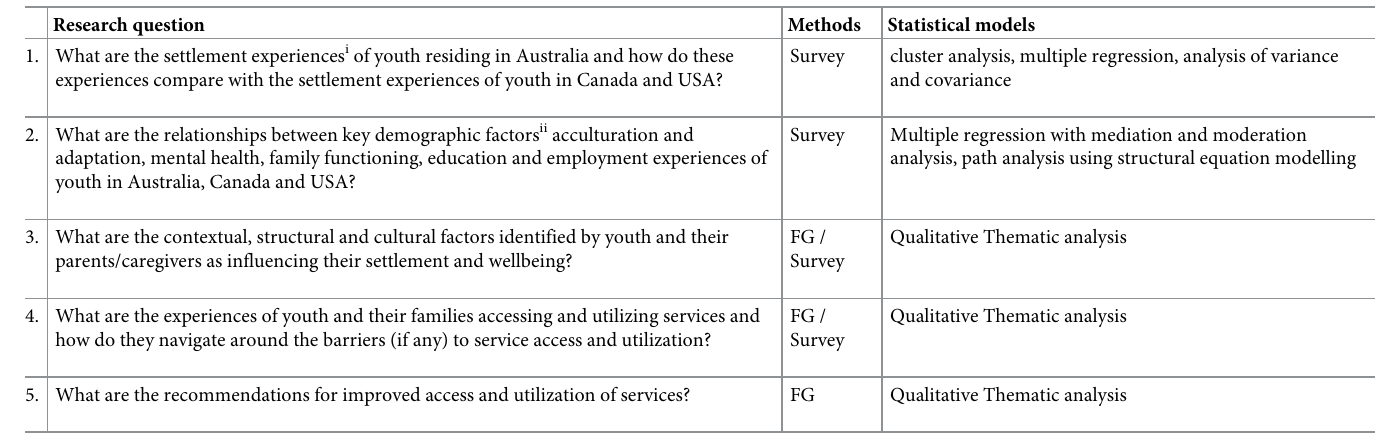
Table 3. Research questions, methods, and statistical